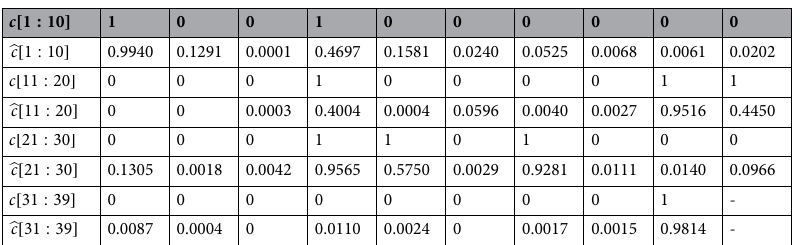
Table 3. An example of reconstruction performed by an AE: vector c is the original sample and vector reconstructed